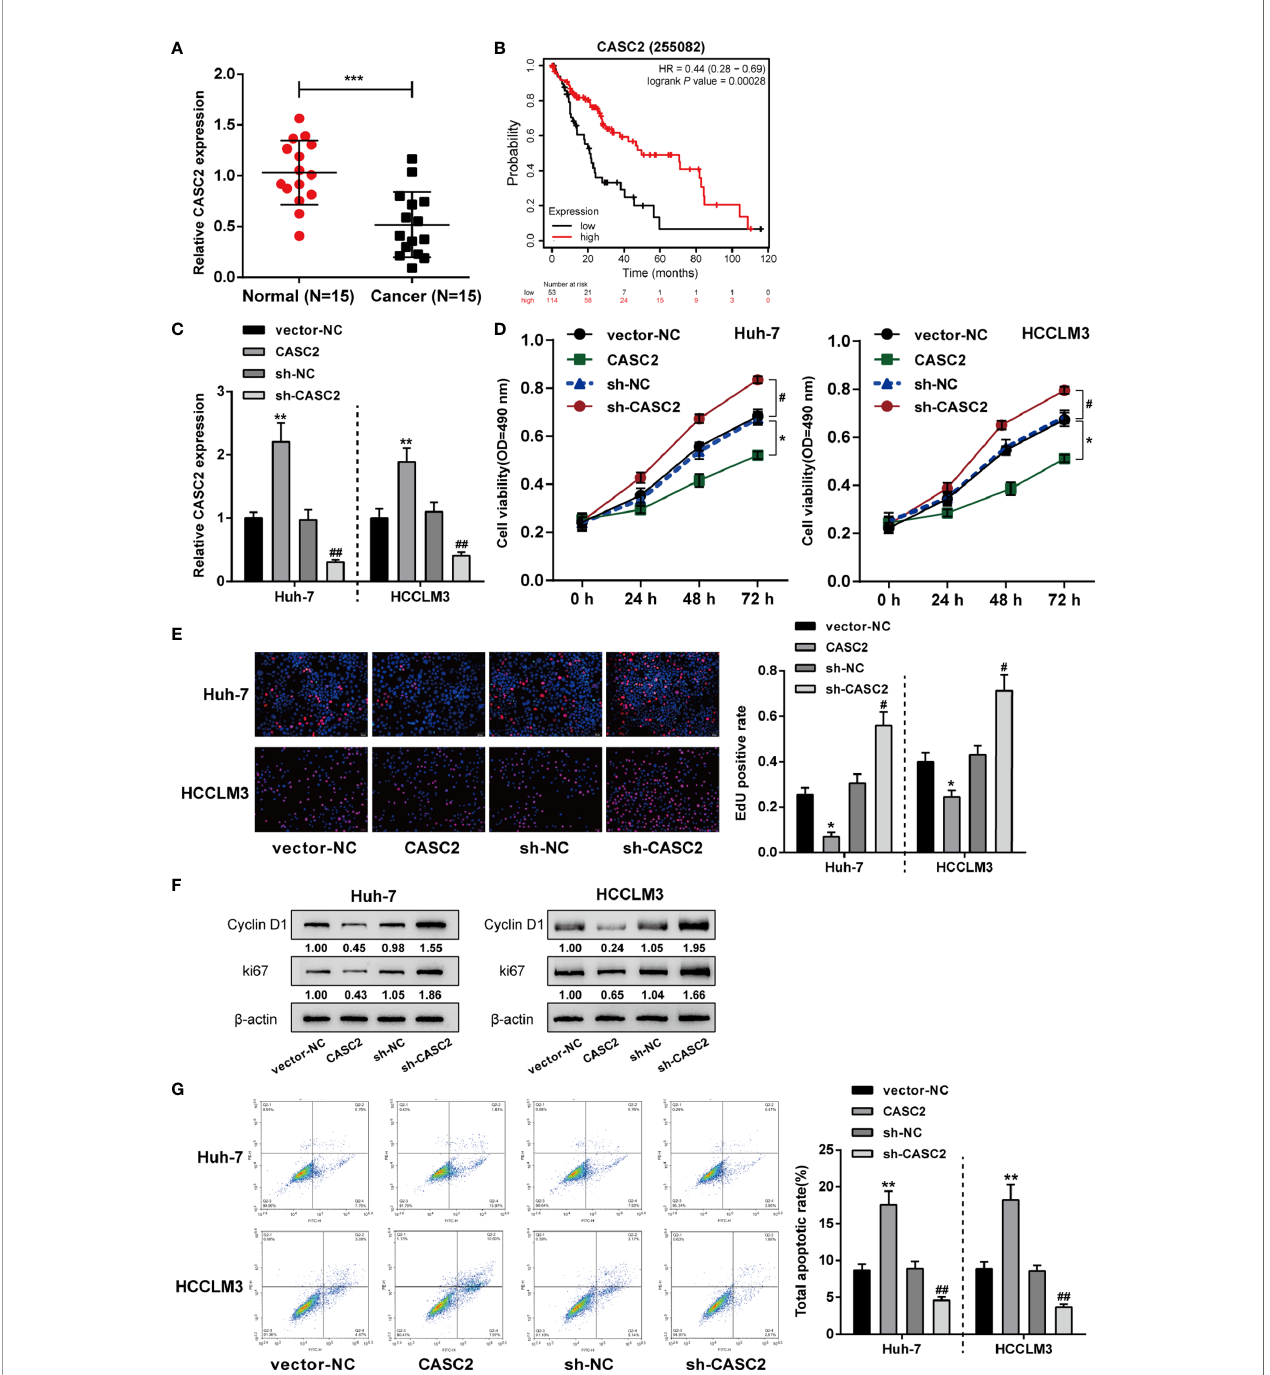
FIGURE 1 | In vitro effects of lncRNA CASC2 on hepatocellular carcinoma (HCC) cells. (A) LncRNA CASC2 expression was determined in HCC (n=15) and adjacent non-cancerous tissues (n=15) using qRT-PCR. (B) The correlation of CASC2 expression and the survival probability of 167 free from hepatitis virus infections HCC patients was analyzed using Kaplan-Meier Plotter online tool (https://kmplot.com/analysis/index.php?p=service) and a log-rank analysis. (C) The overexpression or silencing of lncRNA CASC2 was achieved in cells by transfecting pcDNA3.1-CASC2 (CASC2, empty vector as a negative control) or vector short hairpin RNA targeting CASC2 (sh-CASC2, sh-NC as a negative control). The transfection ef fi ciency was con fi rmed by real-time PCR. Then, HCC cell lines Huh-7 and HCCLM3 were transfected with CASC2 or sh-CASC3 and examined for cell viability by MTT assay (D) ; DNA synthesis capacity by EdU assay (E) ; the protein levels of proliferating markers cyclin D1 and ki67 by Immunoblotting (F) ; cell apoptosis by Flow cytometry assay (G) . *p < 0.05, **p < 0.01, ***p < 0.005 compared with normal or vector-NC group, # p < 0.05, ## p < 0.01, compared with sh-NC